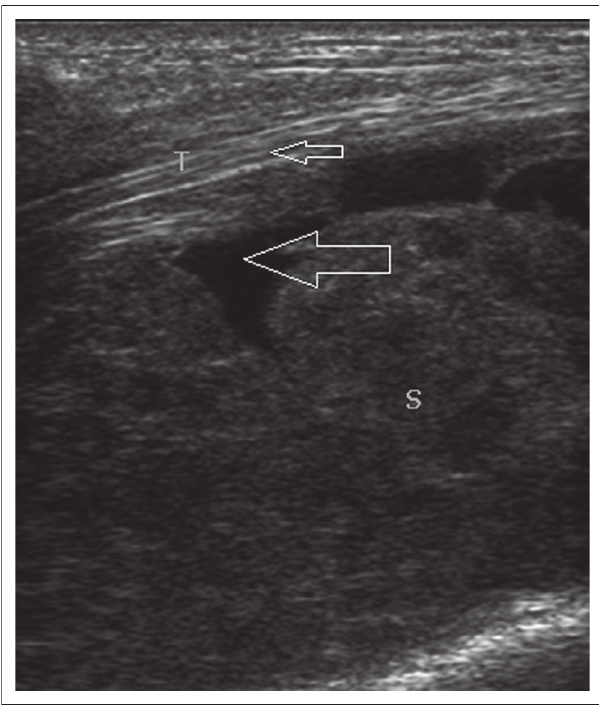
FIGURE 2: Ultrasonography demonstrates heterogenous solid-cystic lesion (larger arrow) in close proximity to the tendon sheath (smaller arrow).